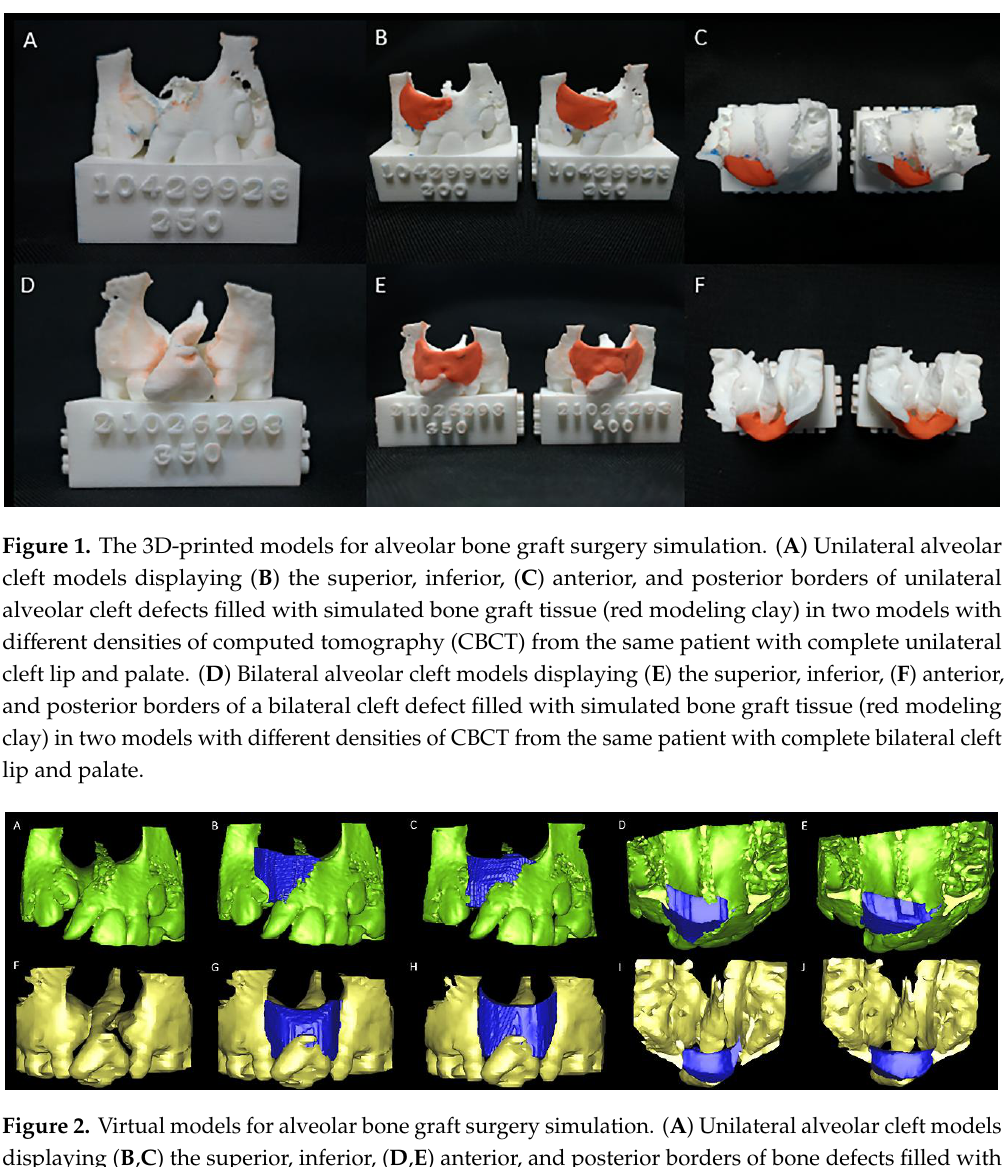
Figure 2. Virtual models for alveolar bone graft surgery simulation. ( A ) Unilateral alveolar cleft models displaying ( B , C ) the superior, inferior, ( D , E ) anterior, and posterior borders of bone defects filled with simulated bone graft tissue (blue) in two models with different densities of CBCT from the same patient with complete unilateral. ( F ) Bilateral alveolar cleft models displaying ( G , H ) the superior, inferior, ( I , J ) anterior, and posterior borders of bone defects filled with simulated bone graft tissue (blue) in two models with different densities of CBCT from the same patient with complete bilateral cleft lip and palate.